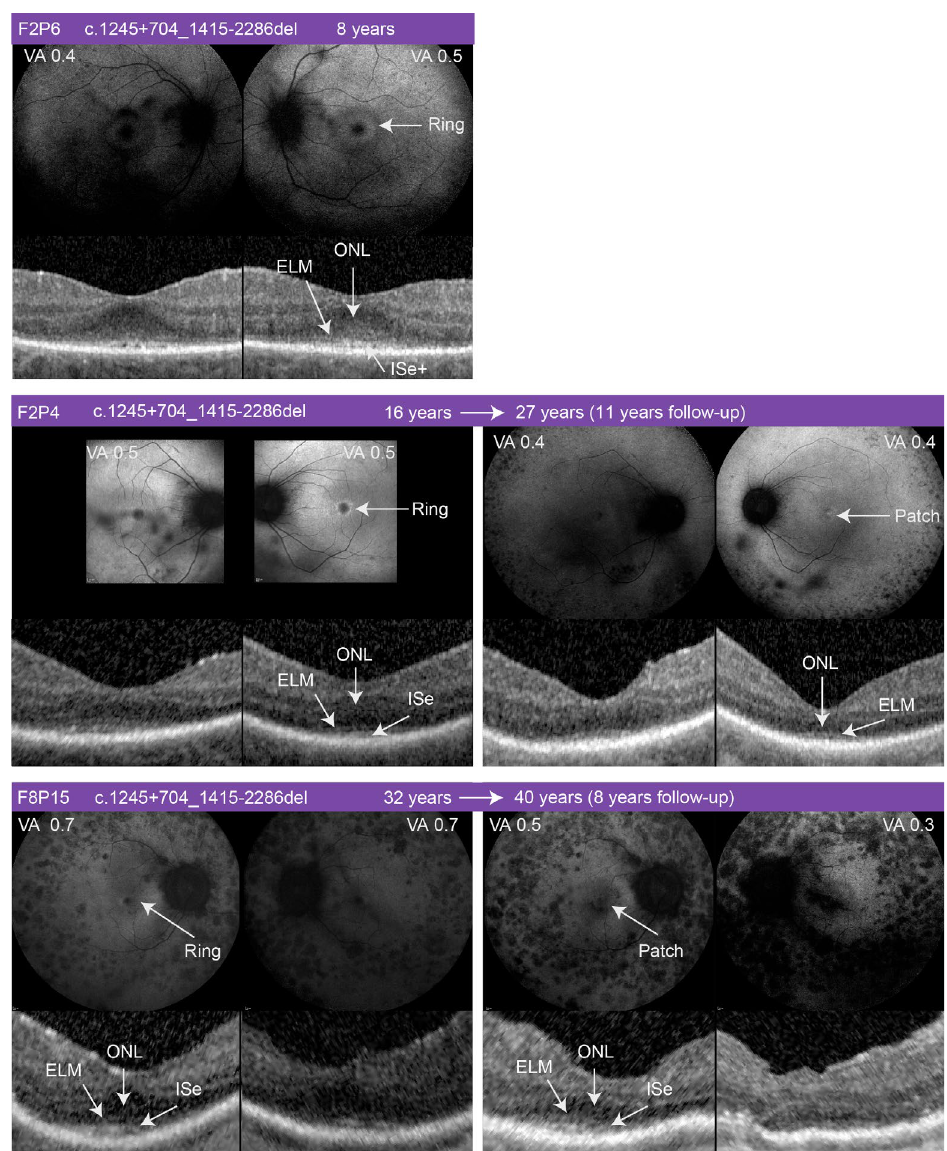
Figure 3. FAF and central OCT of male RP patients from families 2 and 8 harboring the same variant. Follow-up images are presented for patients F2P4 and F8P15 who showed deterioration in the photoreceptor structure in the fovea with time with transitioning from the FAF ring to a patch. RPE—retinal pigment epithelium.